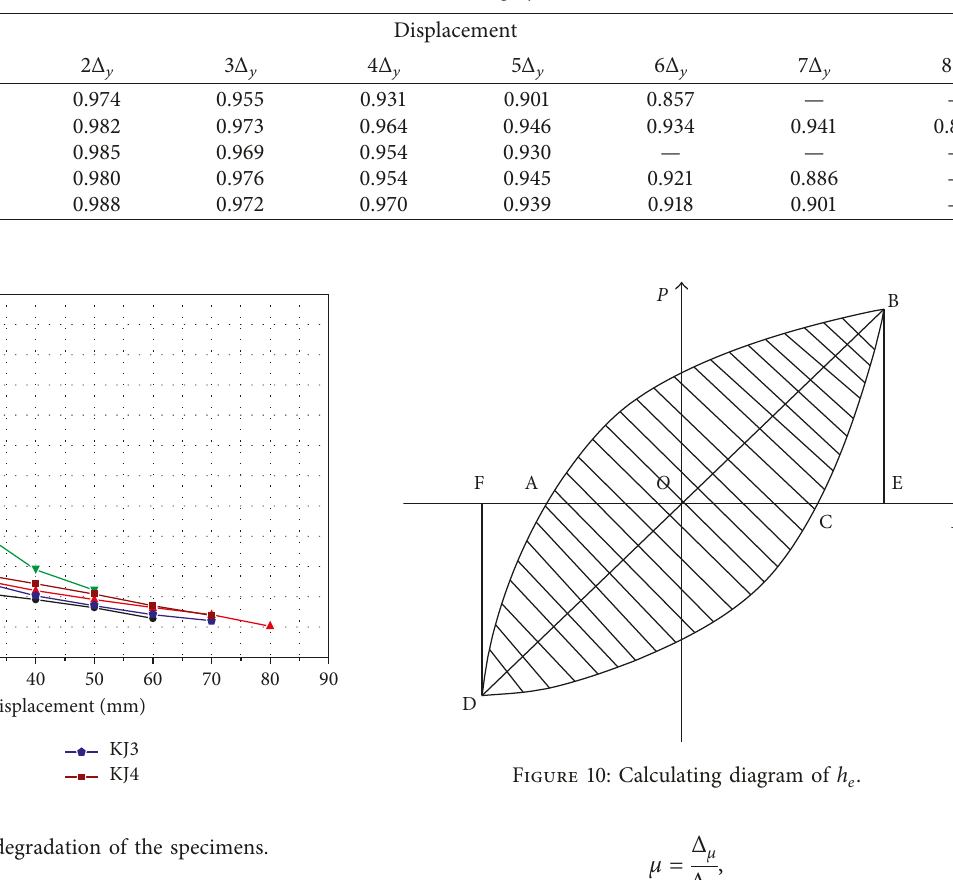
Table 4: Values of λ for each loading cycle.